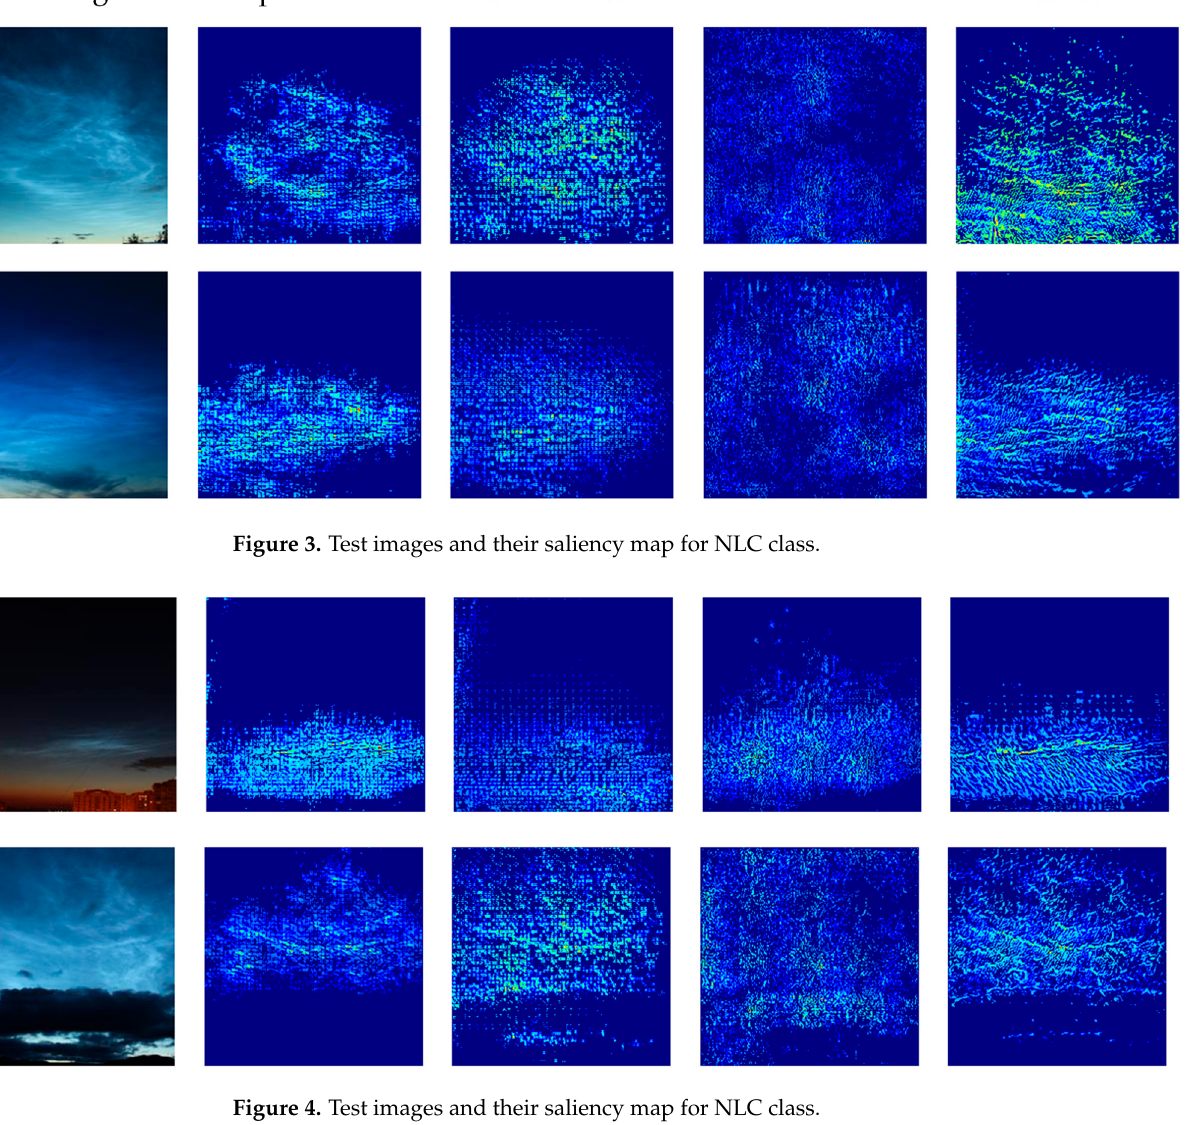
Figure 5. Test image and their saliency map for NLC class.